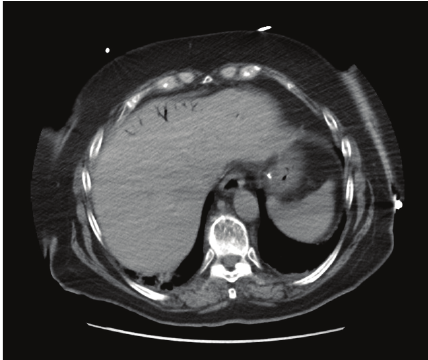
Figure 1: CT image demonstrating portal venous gas.